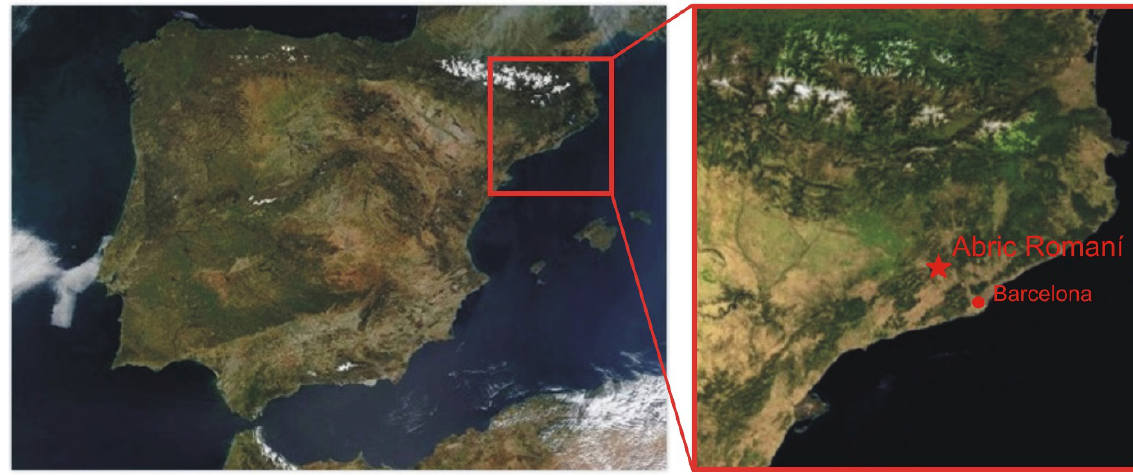
Figure 1. Location of Abric Romaní